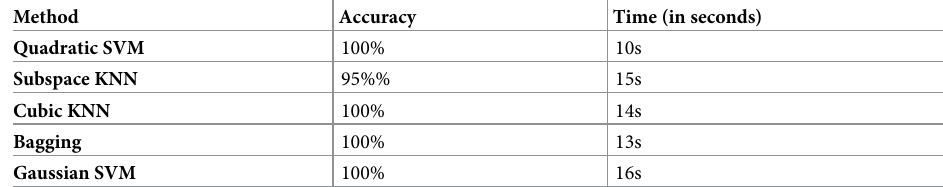
Table 4. Percentage error of alternative SVM algorithms.